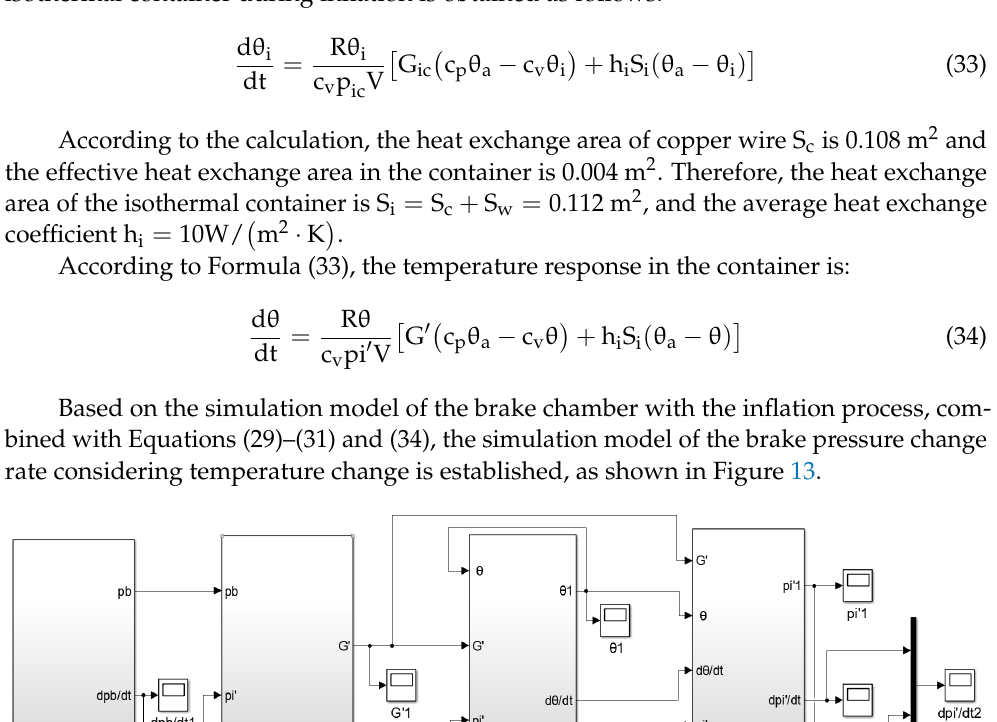
Figure 13. Simulation model of brake pressure change rate considering temperature change. When the air supply pressure is 0.6 MPa and the sonic conductance is 2.2 m 3 /(s · bar), the calculation curve and measurement curve of the brake pressure change rate are ob- tained by simulation, as shown in Figure 14. It can be observed that the measurement curve of brake pressure change rate considering temperature change dp well consistent with the calculation curve of brake pressure change rate theoretical effectiveness of key devices and structural parameters of brake pressure change rate measurement are verified.